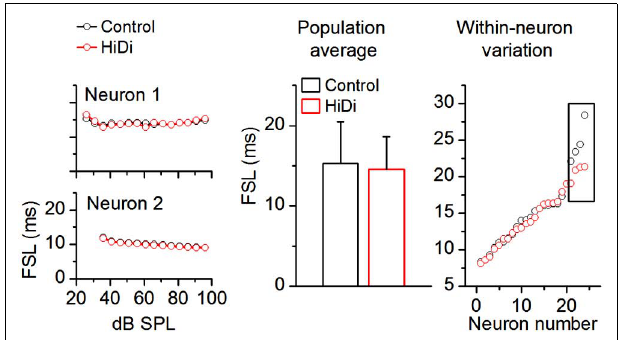
FIGURE 8 | HiDi does not affect most first spike latencies. HiDi does not alter first spike latencies (FSL) in most neurons. Left: examples of FSLs in two neurons. Middle: population average, 82 neurons. Mean ± SD, t 163 = 1.57; p = 0.118. Right: FSL distribution in 24 neurons. Each pair of data points is the FSL for a single cell. Boxed region: in a few cells with long FSLs ( > ∼ 25 ms), HiDi shortened onset latencies by 2–6